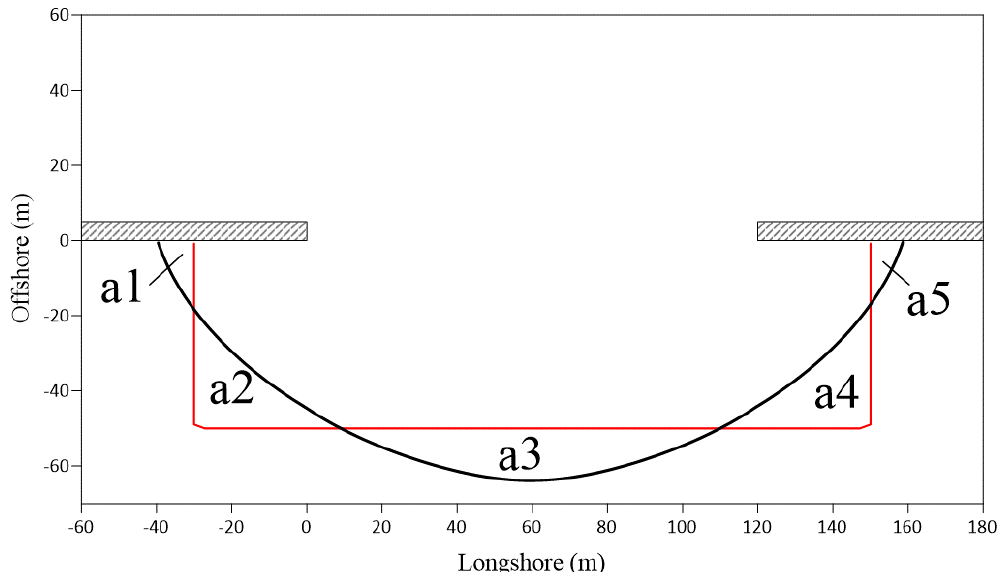
Figure 12. The profiles of steady-state shoreline by using four different angles of incident wave. (m = 179, ∆ t = 0.01 s).